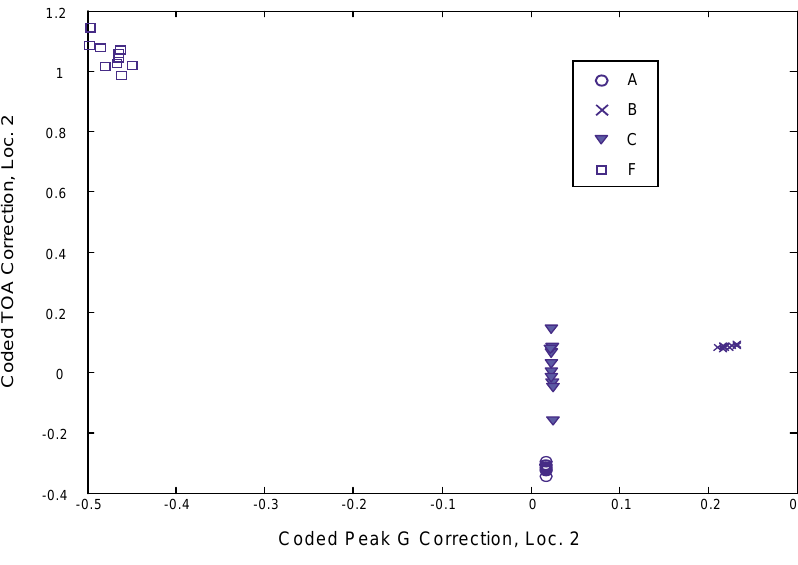
Fig. 13. Comparison of parameter adjustments based on peak G and TOA, output 2.